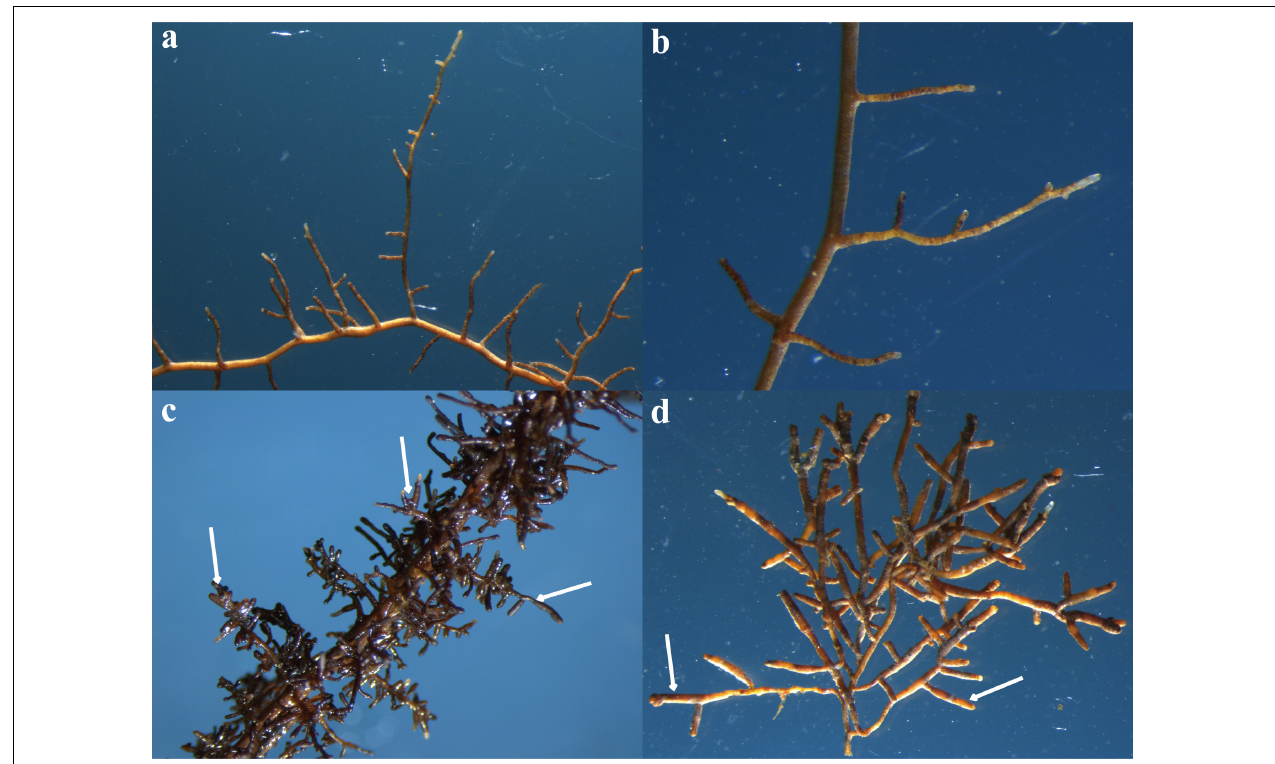
FIGURE 1 | Root tips of Quercus aliena without Tuber indicum (a,b) or with T. indicum partner (c,d) . The white arrows indicate the inflated root tips which are colonized by T. indicum . These pictures were photographed using routine stereo microscopes (M80, Leica Microsystems, Inc., Buffalo Grove, IL, United States) under different magnification. (a) 10; (b) 20; (c) 13; (d)